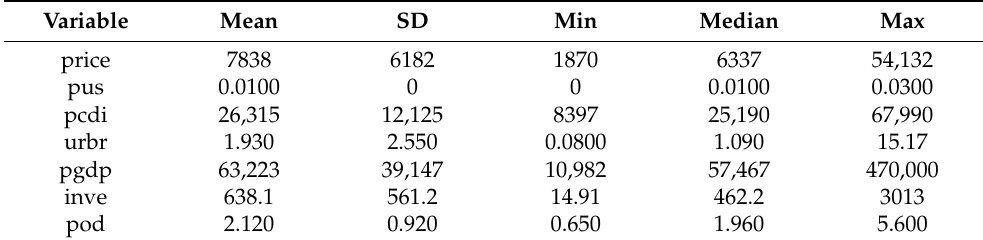
Table 1. Descriptive statistics of key